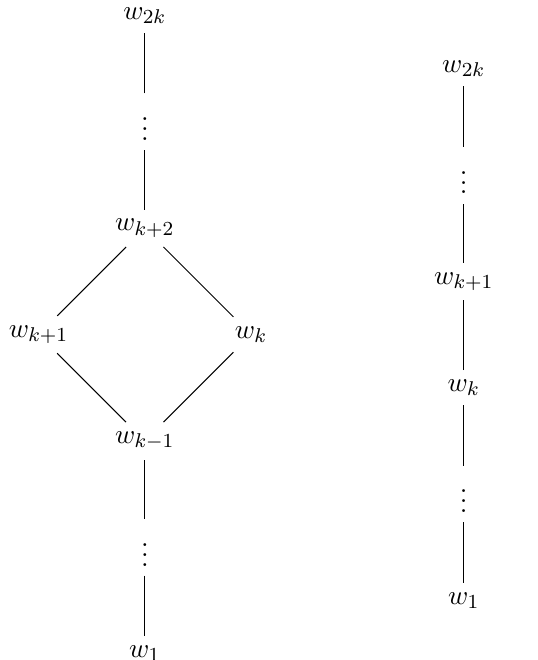
Figure 6 . Bruhat order for W J for D k (left) and B k